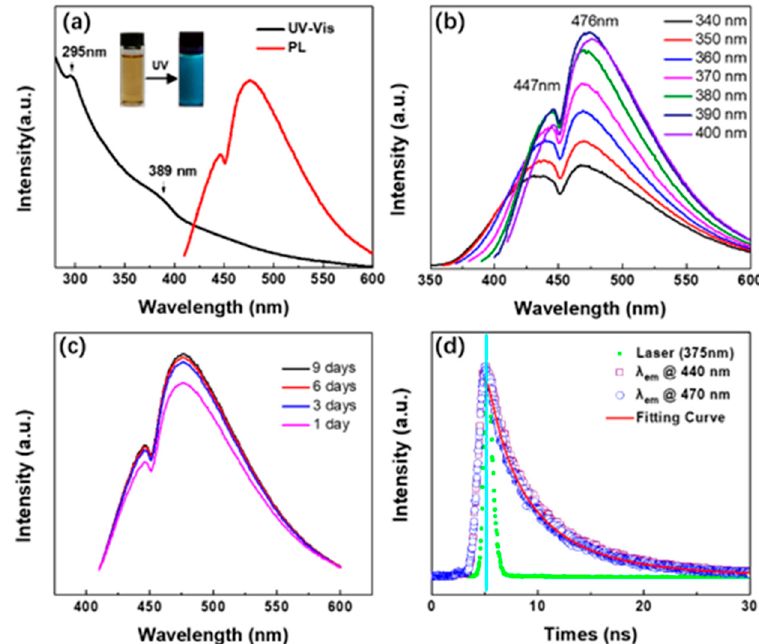
Figure 4. ( a ) Ultraviolet–visible light (UV–Vis) absorption and photoluminescence (PL) spectra of NM-CQDs dispersed in formamide. The insets show the photographs of NM-CQDs under a room light and a UV light source ( λ = 365 nm). ( b ) PL spectra of NM-CQDs excited with different excitation wavelengths. ( c ) PL emission of NM-CQDs excited at 390 nm measured from the first to the ninth day. ( d ) PL decay profiles of NM-CQDs with two emission wavelengths of 447 nm (violet squares) and 476 nm (blue circles). Table 1. Quantum yield and lifetime of N-doped micropore carbon quantum dots (NM-CQDs) compared to other CQDs or graphene quantum dots (GQDs).